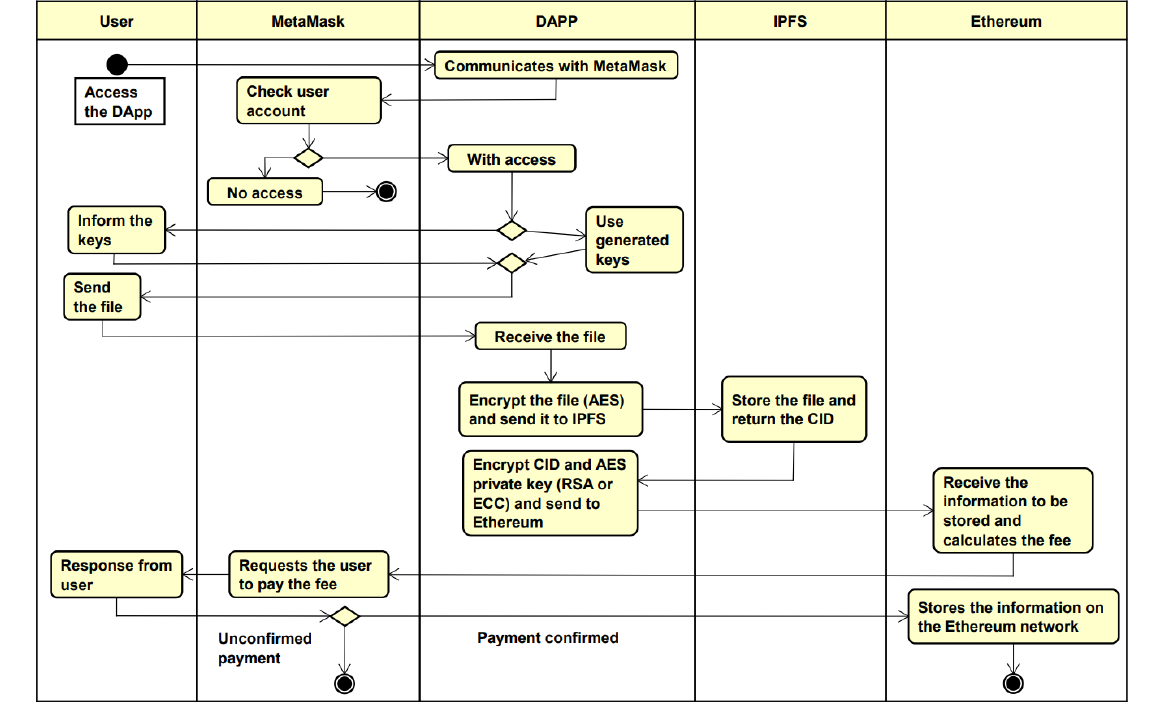
Figure 2. Architecture activity